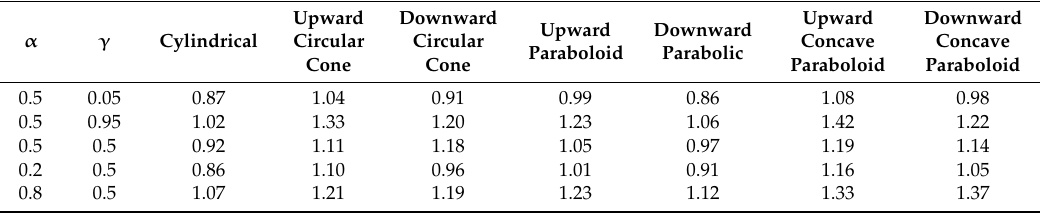
Table 1. Influence of the α and γ on the time response ( T 0.5 ) for all of the geometries. α